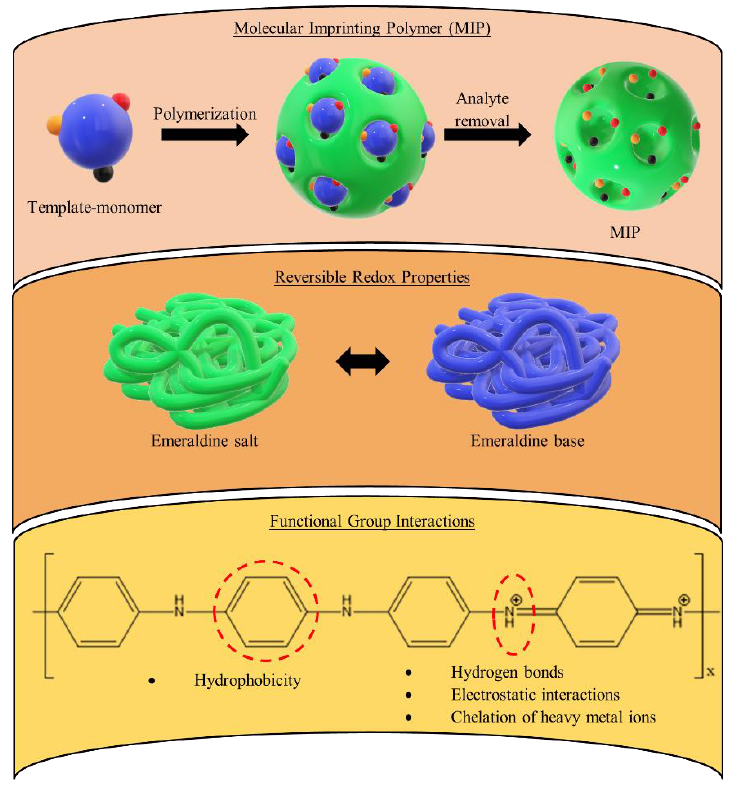
Figure 10. Mechanisms of PANI-based devices for the detection and/or extraction of contaminants in food samples. Table 4. Detection and/or extraction of contaminants such as antibiotics, NSAIDs, and heavy metal ions by PANI-based devices.